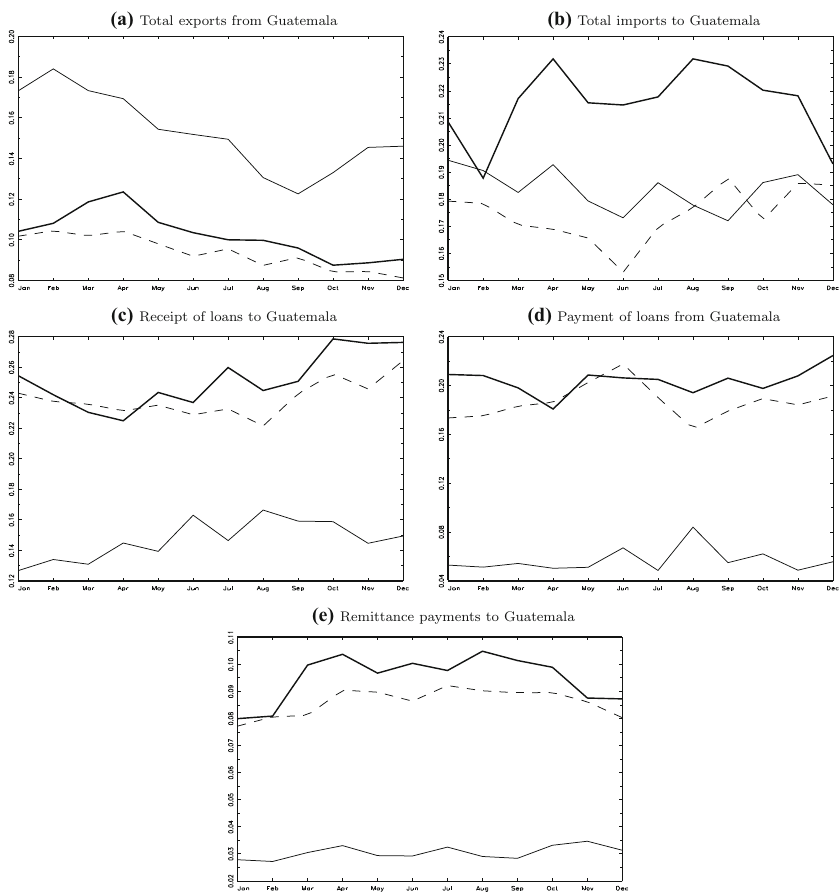
Fig. 4 Relative importance of specific foreign currency movements. Notes R1 is 1994–2000 (solid thin); R2 is 2001–2008 (dashed thin); R3 is 2009–2016 (solid thick). Source of data Bank of